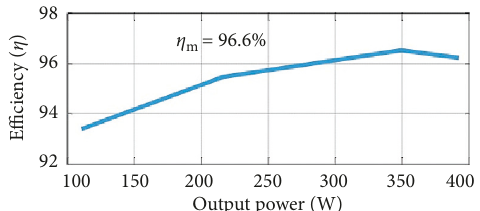
Figure 14: Measured efficiency in terms of output